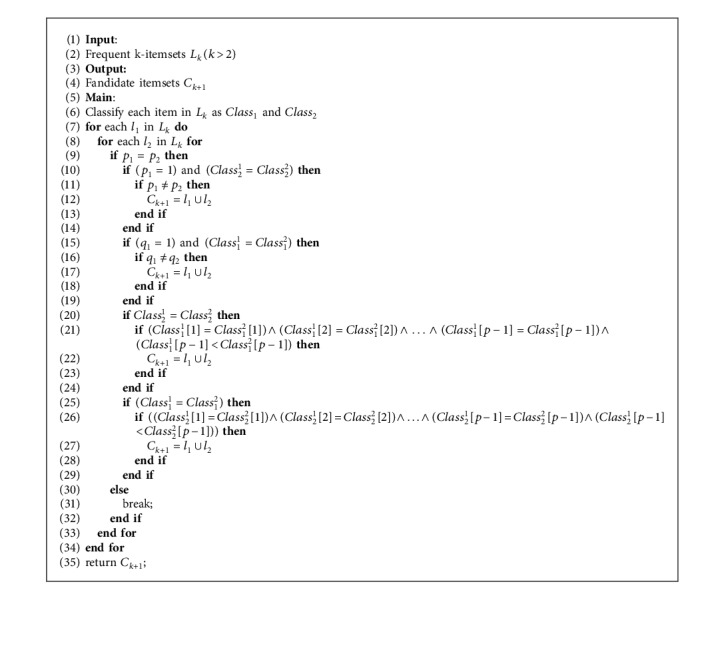
 Generating candidate itemsets Ck+1.